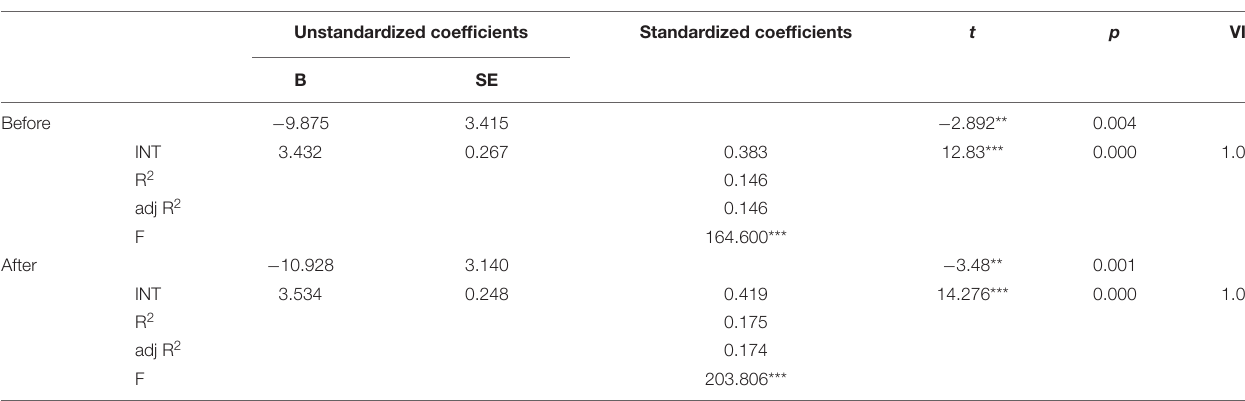
TABLE 5 | Simple linear regression